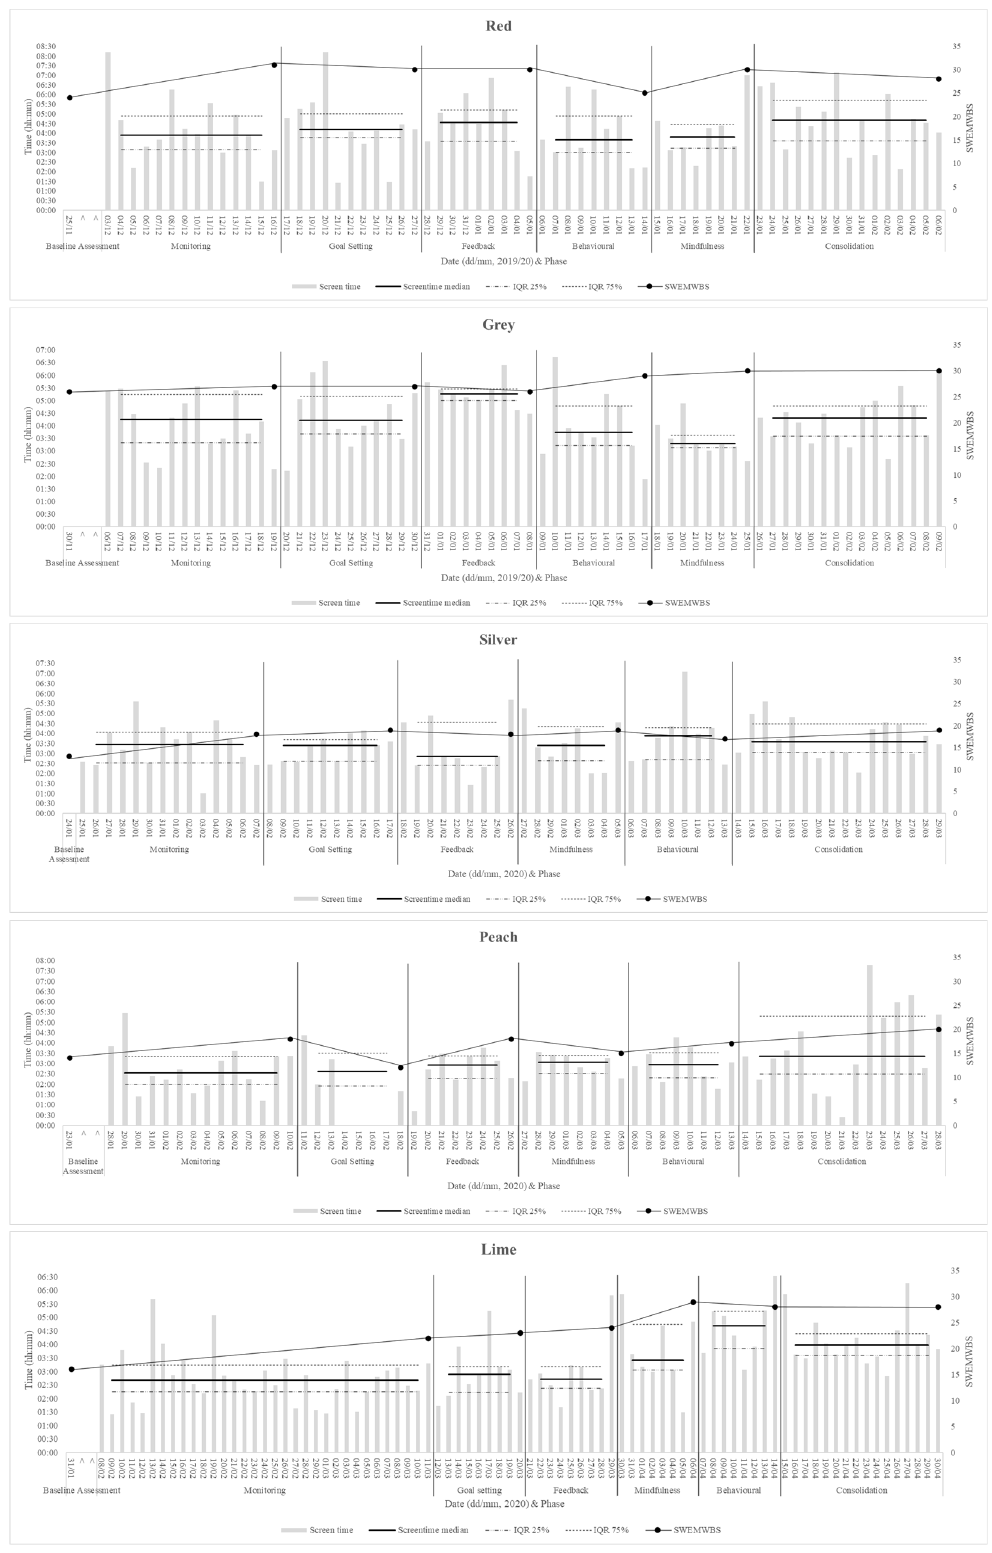
Figure 4. Total daily screen time throughout the participation in the study for each participant, along with the screen time median and interquartile range and the SWEMWBS scores for each phase.